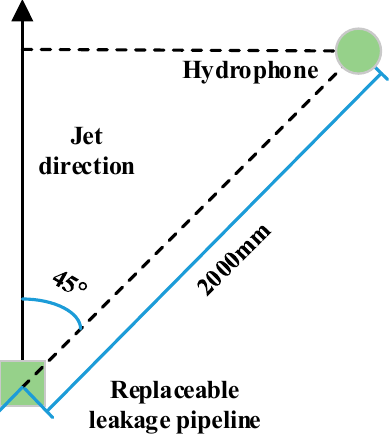
Figure 8. Hydrophone arrangement.